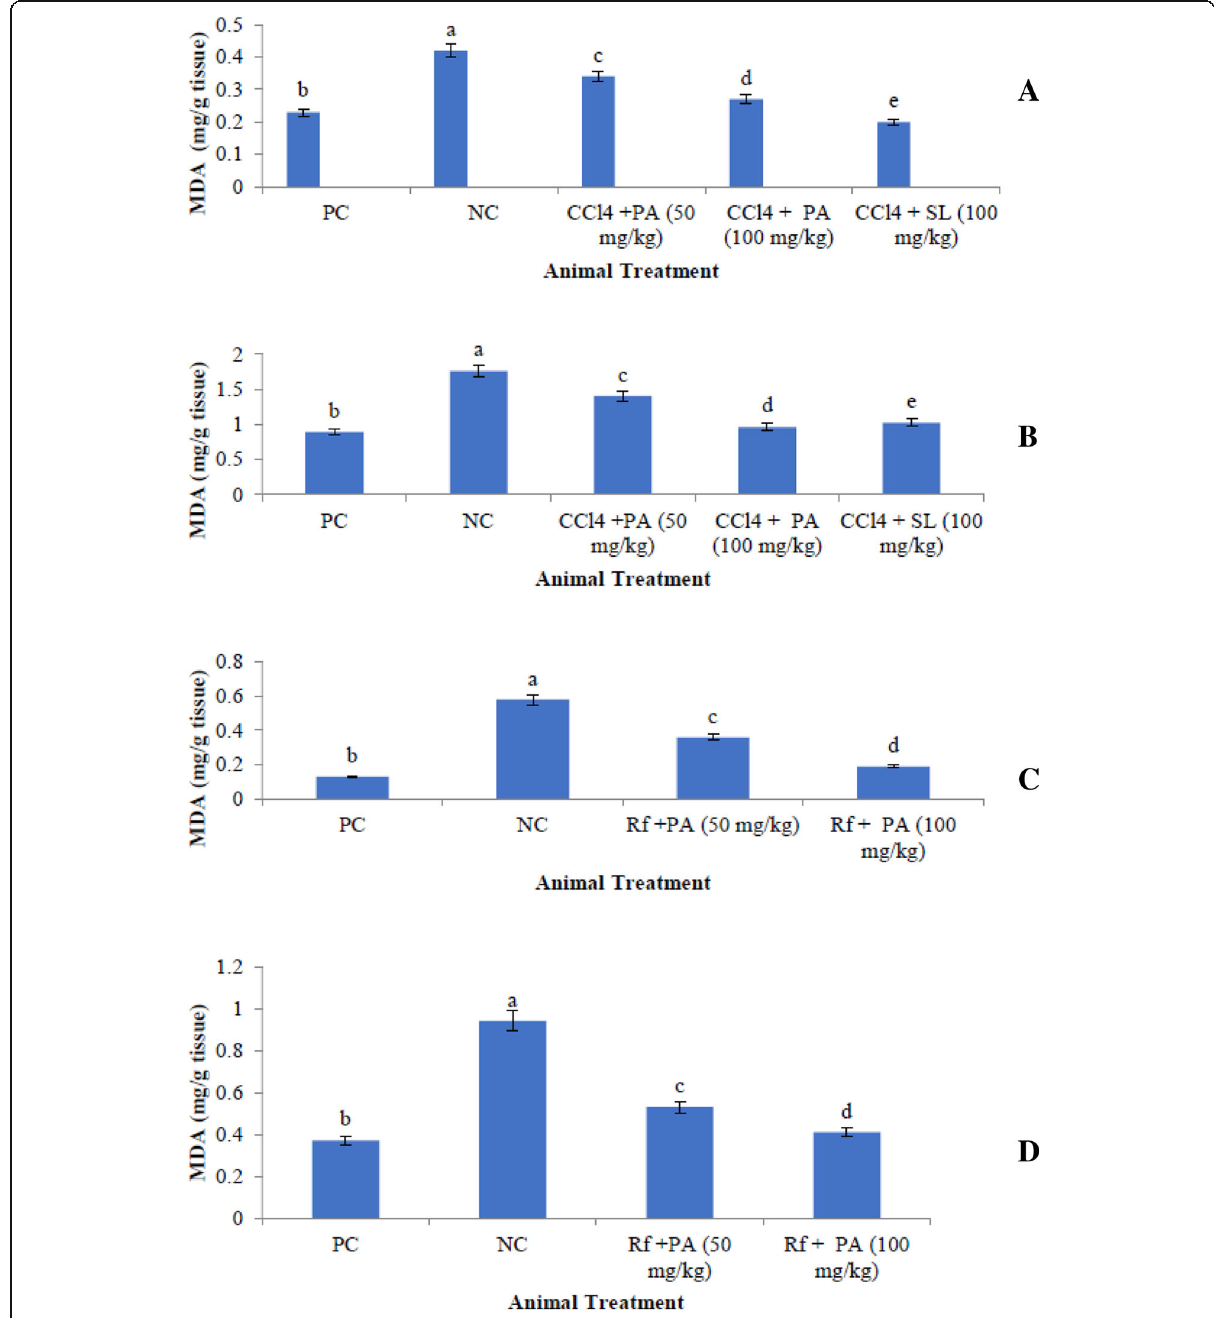
Fig. 3 Effect of P americana leaf extract on hepatic and renal lipid peroxidation in albino rats exposed to CCl 4 and rifampicin toxicity. Data shows mean ± SEM values of four independent experiments performed in triplicate. ‘ b ’ , ‘ c ’ , ‘ d ’ and ‘ e ’ represent significant difference ( p < 0.05) from ( ‘ a ’ ) - the positive control (NC); PC- negative control; PA- Pearse americana ; SL- Silymarin. Rf- Rifampicin. MDA- a and b are liver and kidney of CCl 4 – challenged rats respectively. c and d are liver and kidney of rifampicin-challenged rats